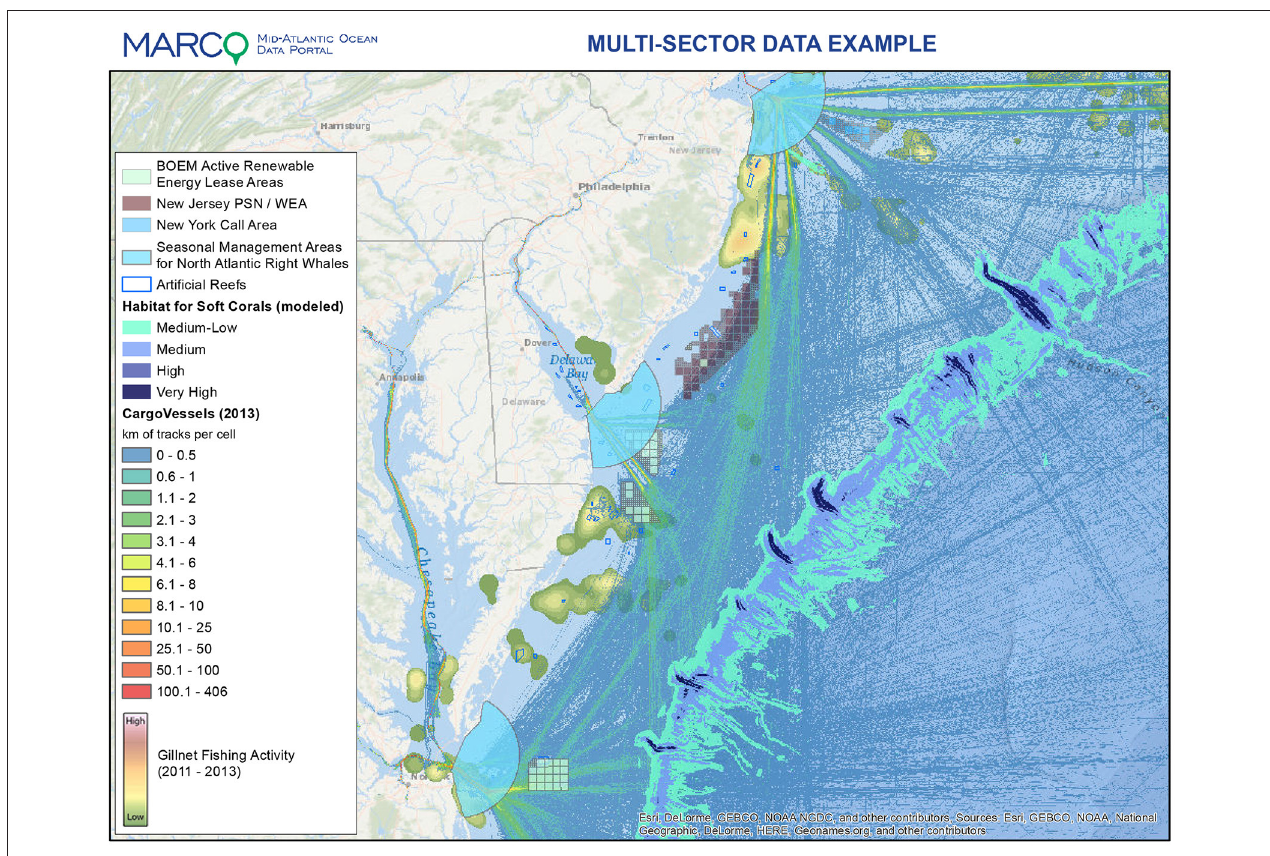
FIGURE 1 | Graphic of the Mid-Atlantic Ocean Data Portal Marine